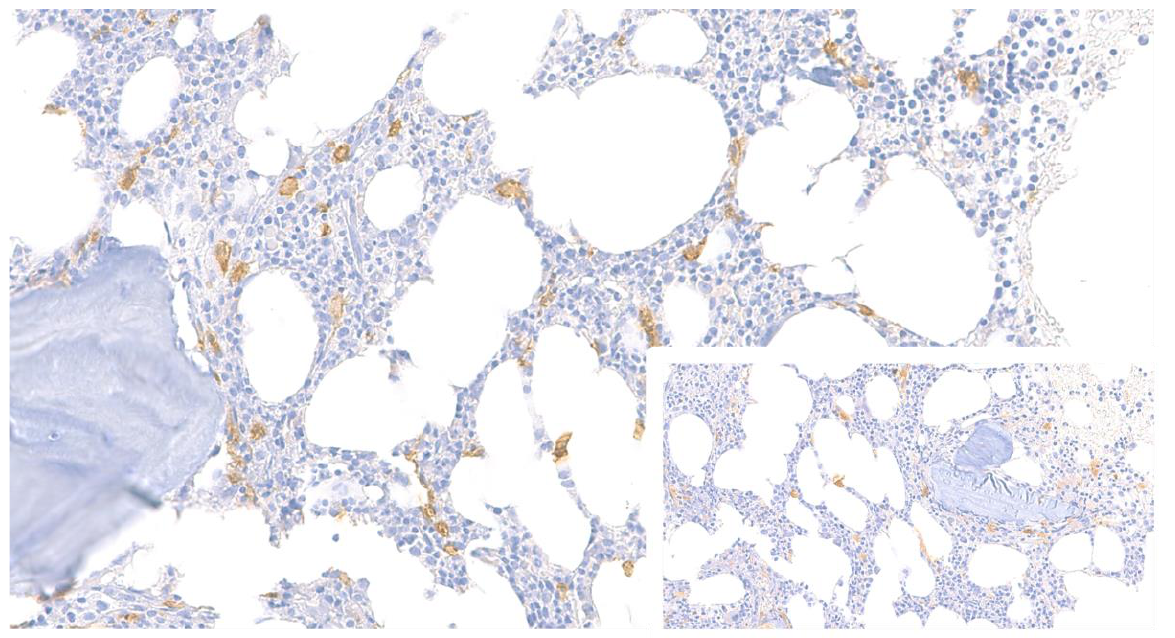
Figure 3. Case 3. Increased interstitial MCs highlighted by CD117 (×400) showing aberrant expres- sion of CD25 (inset, ×400).